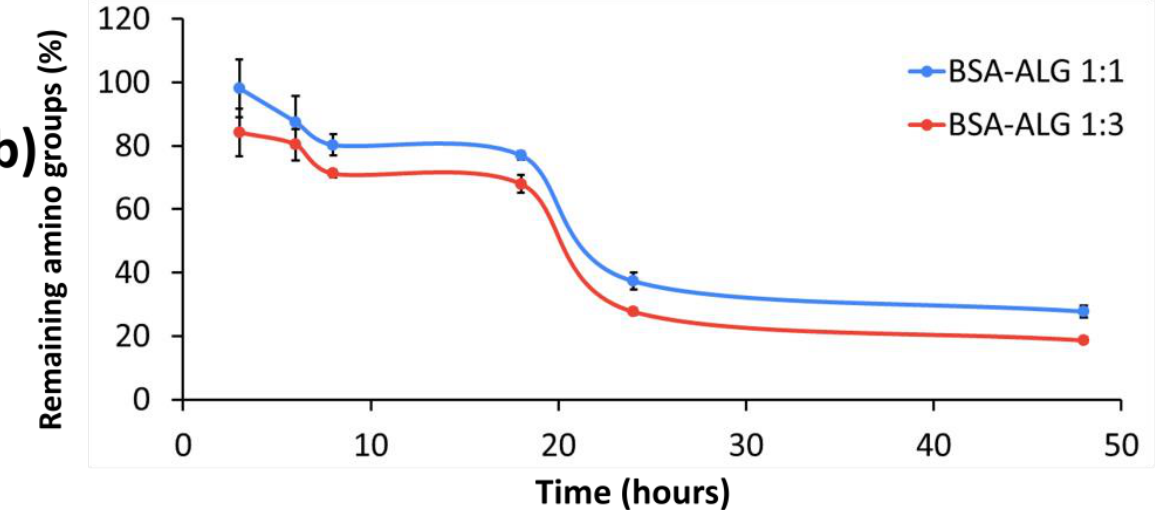
Figure 6. Remaining free primer amino groups of BSA conjugates: ( a ) BSA–ALG 1:1 (blue line) and 1:3 (red line); ( b ) BSA–LBG 1:3 (blue line) and 1:6 (red line).